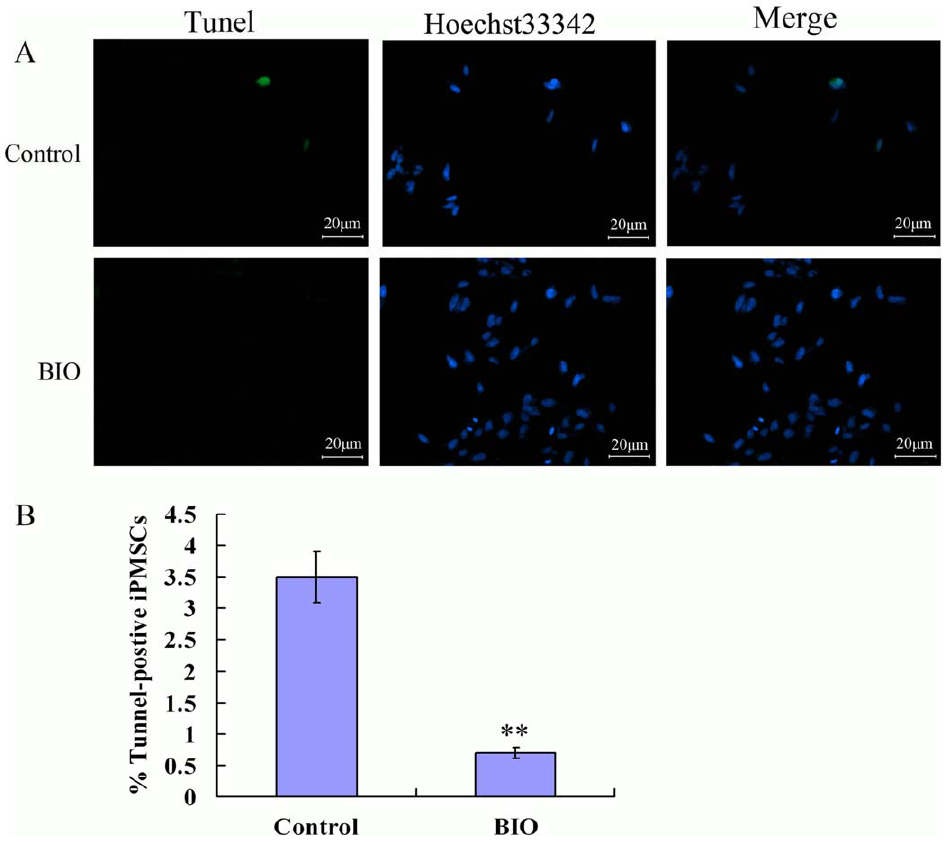
Figure 5. Tunel staining analysis iPMSCs cultured with BIO or not. Bar=20 m m, **P , 0.01. doi:10.1371/journal.pone.0031502.g005 (Figure 3C, Figure S5). Similarly, the expression of the b -catenin protein was increased in the presence of BIO, as shown by western blotting (Figure 2D). The b -catenin/Tcf activity driven from the TOP-Flash luciferase reporter containing functional Tcf-binding sites transfected into iPMSCs was enhanced after 3 days in 1.0 m M